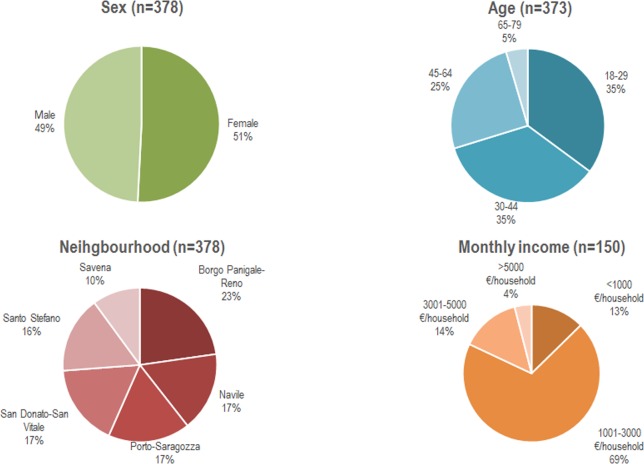
Characteristics of the sample in terms of sex, age, neighborhood and monthly income.